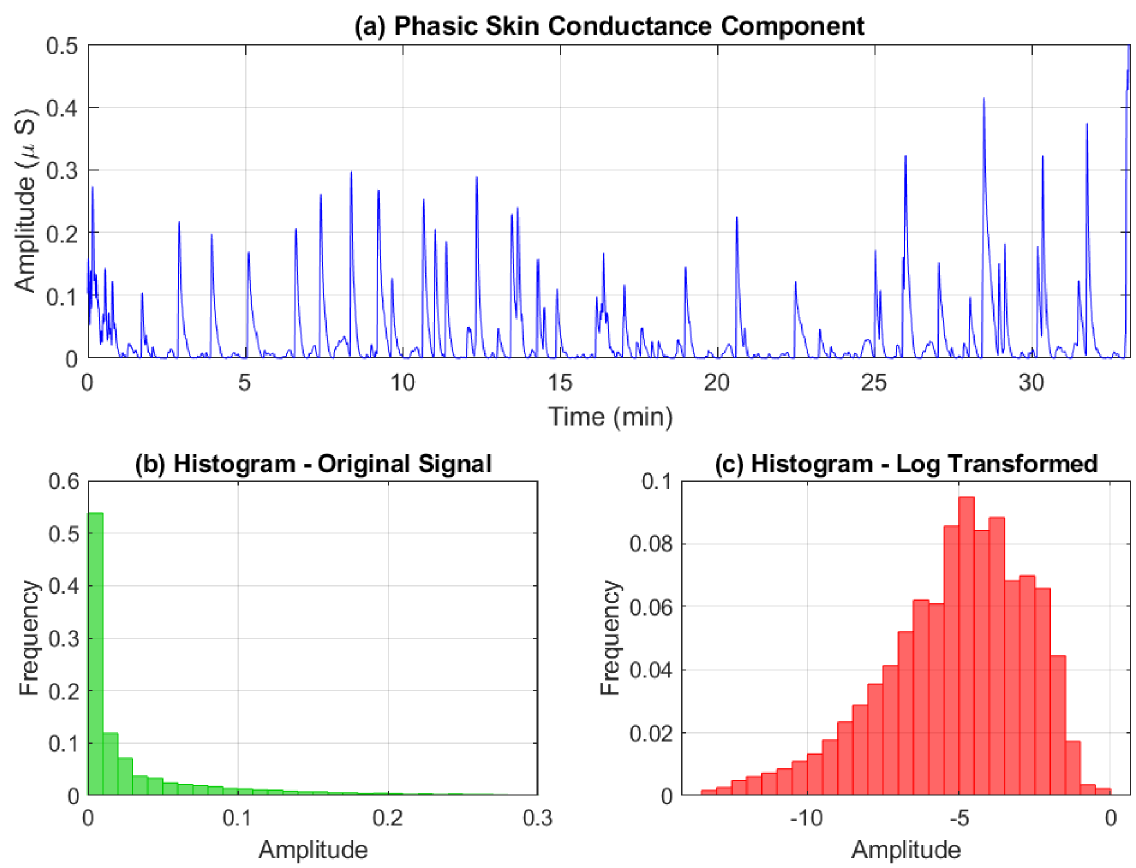
Fig 2. Phasic skin conductance skew correction. The phasic component of a skin conductance signal fluctuates more rapidly than its tonic counterpart and has a positively skewed amplitude histogram. The upper sub-panel depicts the phasic skin conductance from participant 1 extracted using cvxEDA. The lower sub-panels show the the amplitude histograms before and after a log transformation.